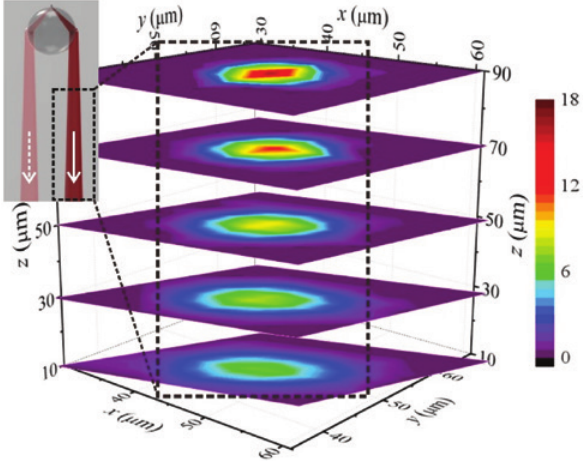
Figure 2: Nanotip-induced emission pattern measured at different positions from the resonator. Inset: sketch illustrating the light emission from the microsphere resonator to free